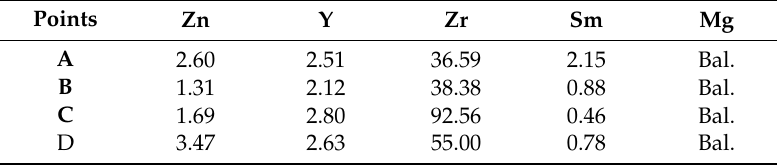
Figure 8. High magnification SEM images of Zr in the as-cast Mg-3Y-3.5Sm-2Zn-0.6Zr alloy: ( a,c ) Without UST; ( b,d ) with UST. Table 4. EDS results corresponding to the selected points in Figure 8 (at Table 3. EDS results corresponding to the selected points in Figures 8 (wt %).